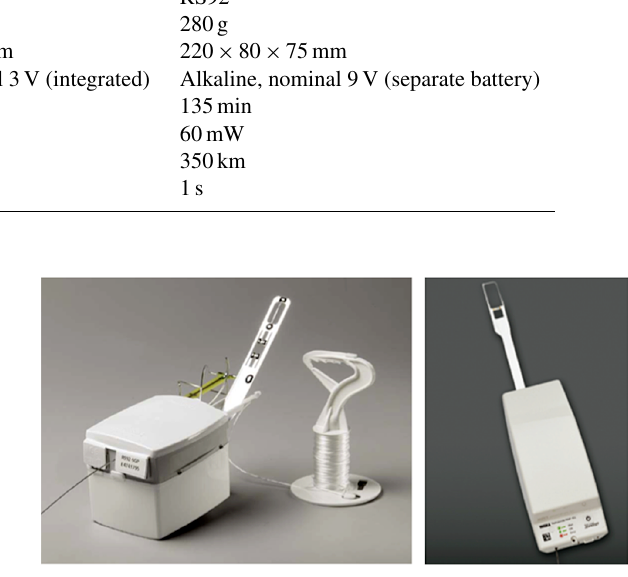
Table 1. Summary of key physical characteristics of the RS41 and RS92 radiosonde models (based on Table 1 from Jauhiainen et al., 2014). Radiosonde characteristic